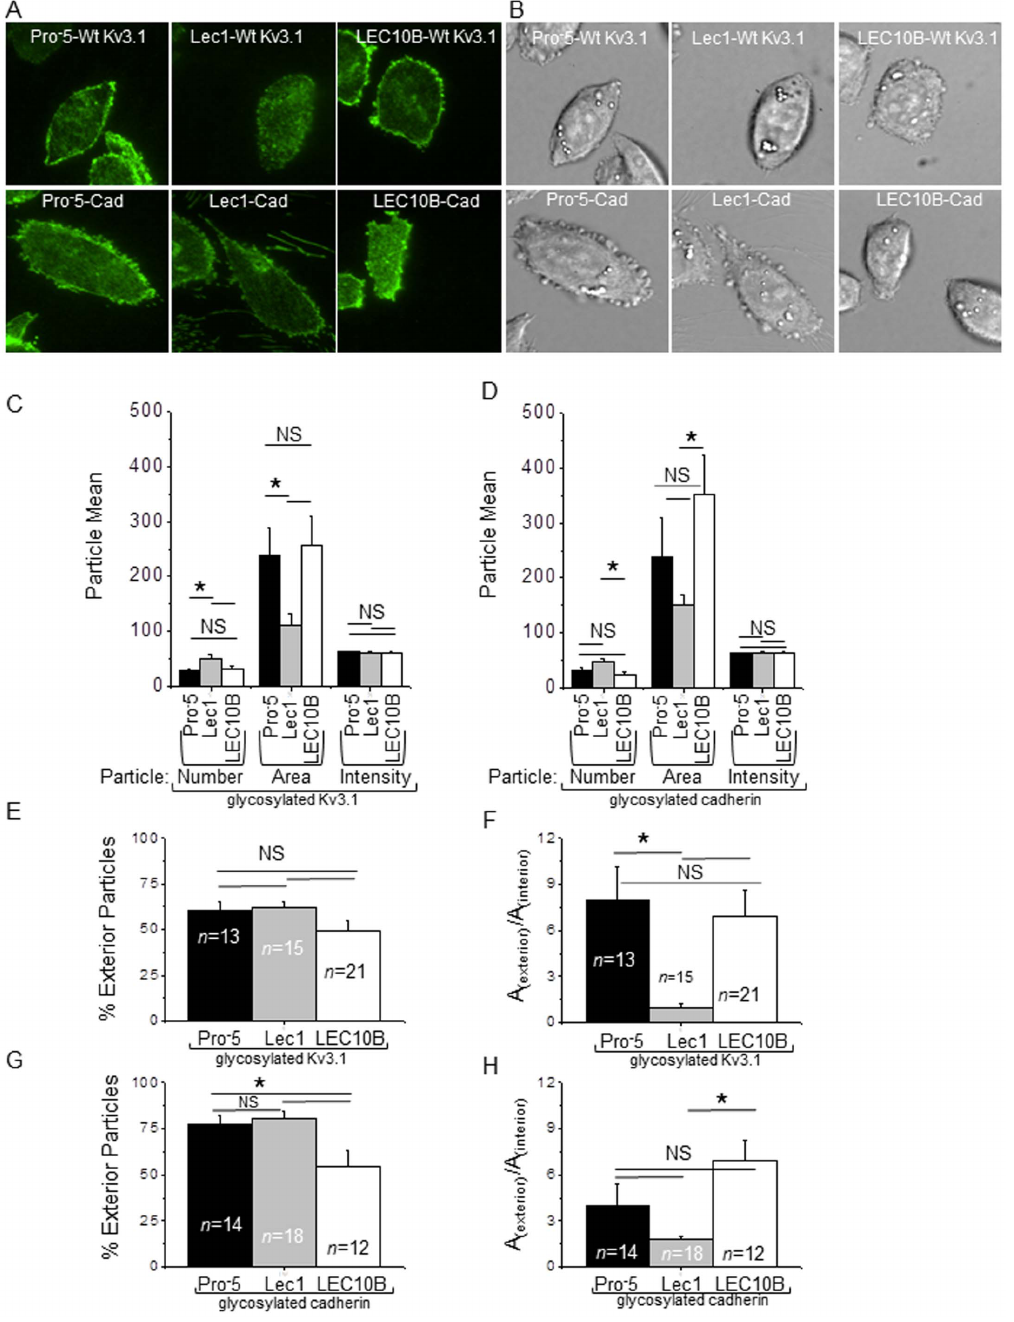
Figure 4. Distribution of Kv3.1 and E-cadherin at the cell surface of single cells. TIRF (A) and DIC (B) microscopy images of Pro - 5 (left panels), Lec1 (middle panels) and LEC10B (right panels) cells expressing either Kv3.1 (upper panels) or E-cadherin (lower panels) are shown. Representative graphs of the mean particle numbers, areas (pixels), and intensities (AU) for Kv3.1 (C) and E-cadherin (D) are shown. The percent of particles located in the exterior region of the cell for Kv3.1 (E) and E-cadherin (G) was determined. The particle area in the exterior of the cell relative to the particle area in the interior of the cell for Kv3.1 (F) and E-cadherin (H) was calculated. doi:10.1371/journal.pone.0075013.g004 exclusion of the cell-cell interface, and in exterior border of the forms of the glycoprotein (Figure 3L). Mean area of the particles in membrane patch. The percent of interior membrane particles for the total membrane patch for Kv3.1 expressed in Lec1 cells the Kv3.1 glycoprotein with either sialylated complex or bisecting (80 6 13 pixels, n = 14) was smaller than those expressed in Pro - 5 type N -glycans were at least 2-fold lower than that with (143 6 19 pixels, n = 12) and LEC10B (136 6 19 pixels, n =15) while oligomannose N -glycans (Figure 3K) which correlated with the the number of particles in the total membrane patch for Kv3.1 higher percent of exterior membrane particles for the earlier two expressed in Lec1 cells (55 6 7 particles, n =14) was slightly larger